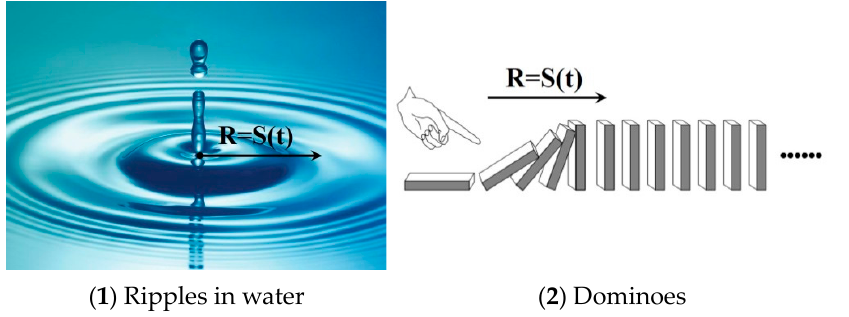
Figure 3. Influence radius of ripples in water and dominoes (used as an analogy to describe the influence radius discussed in this paper). R is the influence radius, [L]; S is the distance in physics, [L]; and t is time, [T].